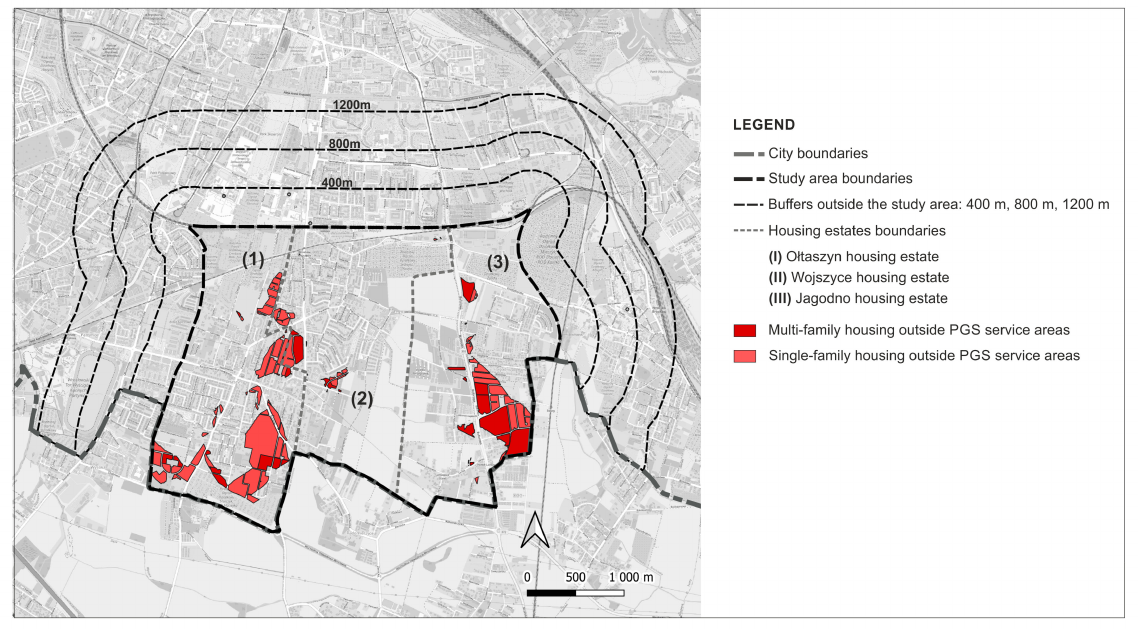
Figure 15. Residential sites not served by any PGS according to land use plans.